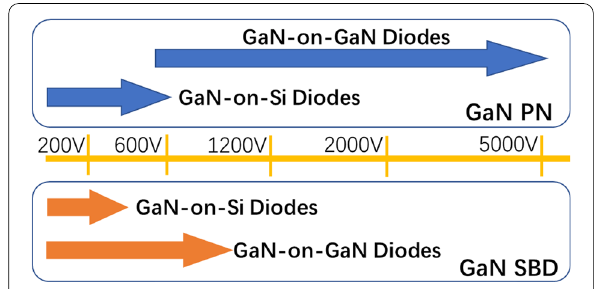
Fig. 2 Overview of the device types, reports, and voltage classes of main vertical GaN power devices reported in recent years